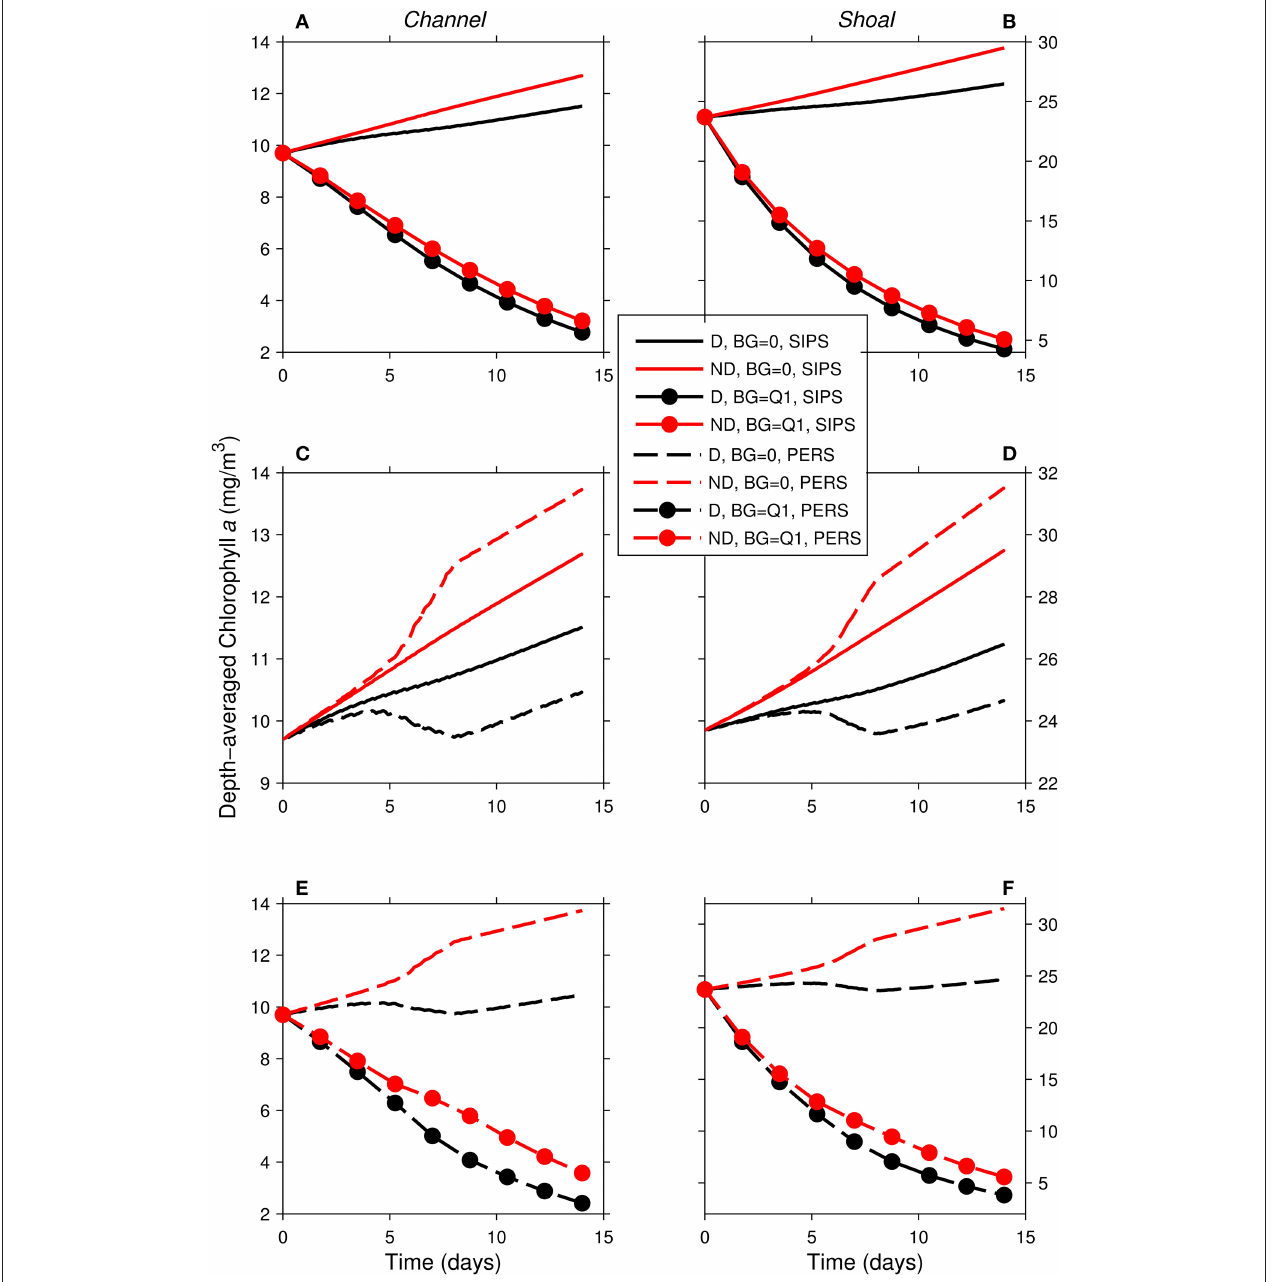
FIGURE 10 | Time series of computed depth-averaged phytoplankton biomass for shoal-channel system representative of Suisun Bay. Results from eight 14-day simulations are shown. Diatoms (“D,” black) were assigned a sinking speed of 3m/d; non-diatoms (“ND,” red) had a sinking speed of 0m/d. “SIPS” (solid lines) represents strain-induced periodic stratification in the channel. “PERS” (dashed lines) represents persistent neap-tide stratification in the channel. SIPS (with and without benthic grazing) for the (A) channel and (B) shoal. SIPS and PERS with BG = 0 for the (C) channel and (D) shoal. PERS (with and without benthic grazing) for the (E) channel and (F) shoal. “Q1” indicates that the historical first quartile benthic grazing rates were used. See Table 2 for BG and other parameters implemented.